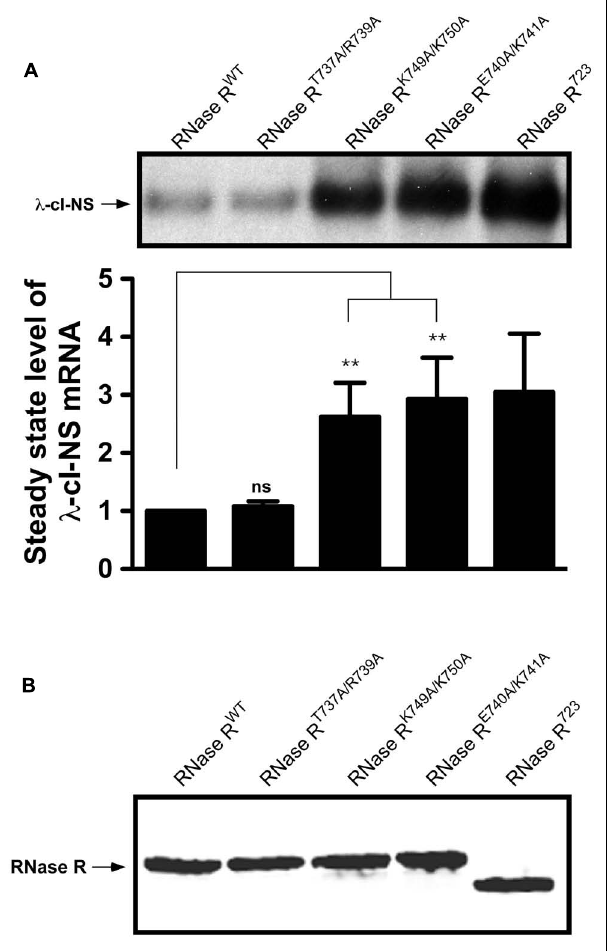
FIGURE 3 | Non-stop reporter mRNA accumulates in the presence of RNase R K749A/K750A , and RNase R E740A/K741A . (A) A representative Northern blot showing the steady state level of non-stop mRNA in the presence of RNase R T737A / R739A , RNase R K749A / K750A , and RNase R E740A / K741A .The latter two variants are defective in non-stop mRNA degradation. P -values were calculated by performing student’s t -test analysis with RNase R WT and RNase R K749A / K750A ( ∗∗ P < 0.005) or RNase R WT and RNase R E740A / K741A ( ∗∗ P < 0.003).The graph represents the fold change in the steady state level of λ -cI-NS mRNA in the presence of indicated RNase R variants with respect to RNase R WT .The data are representative of three independent experiments (MEAN ± SEM, standard error of the mean). ns = not statistically significant. (B) Steady state levels of RNase R variants are similar. A representativeWestern blot examining the relative steady state levels of RNase R and its alanine-substitution variants is shown. MG1655 rnr strain harboring each p rnr variant plasmid was grown in LB with 0.01% arabinose and 30 μ g/ml of chloramphenicol. Equal numbers of cells were harvested in mid-log phase and processed for Western blot analysis, using RNase R specific